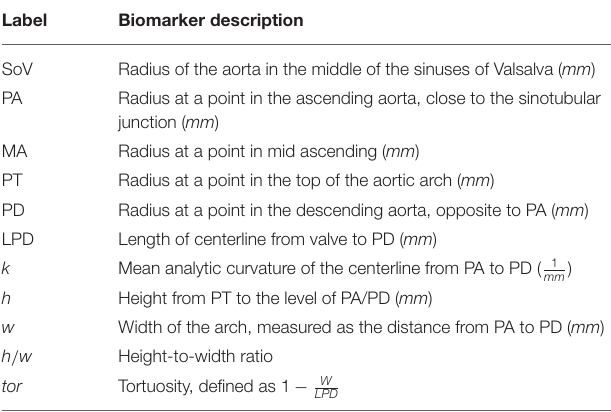
TABLE 1 | List of biomarkers used to describe the thoracic aorta geometry. Label Biomarker